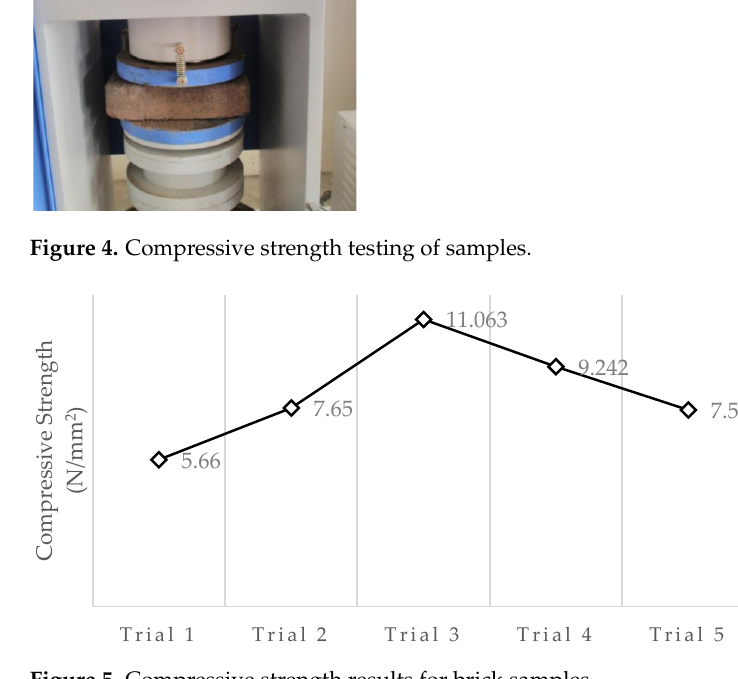
Figure 5. Compressive strength results for brick samples